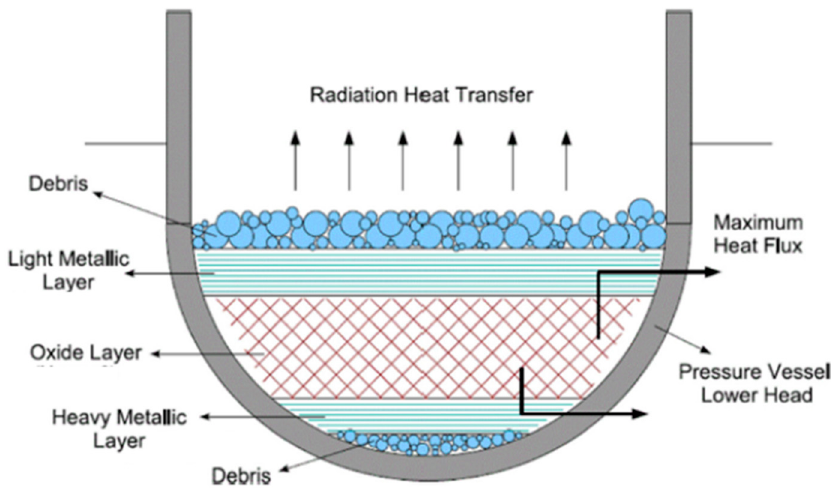
Figure 5. Lower head geometry—stratification and interface heat exchange fluxes.